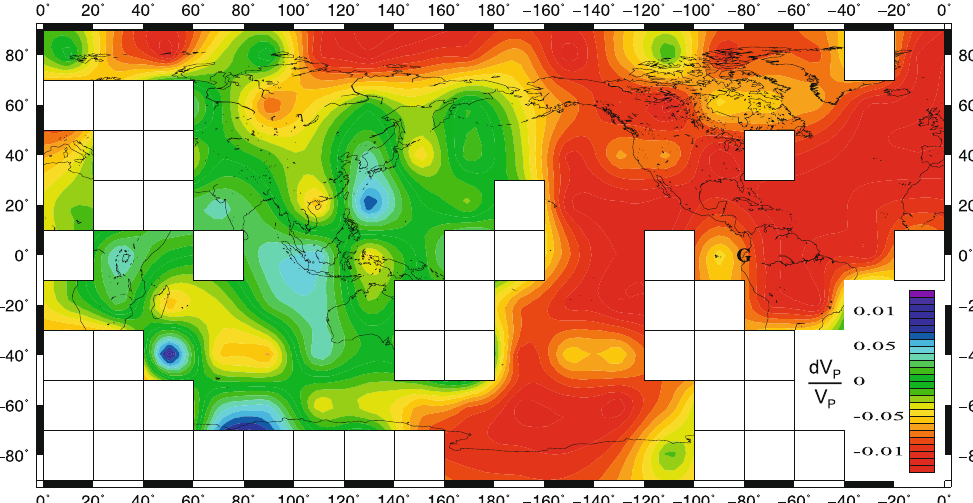
Figure 4. Velocity perturbations at the top of the inner core (first layer beneath ICB in ak135 model, depth from 0 to 51.11 km beneath ICB). Data have been interpolated with kriging method 34 and a low smoothing. White squares show the areas where the small number of rays did not allow reliable results. The model explains more than 80% in the initial variance (evaluated for null velocity perturbations). Point G at (0°, 80°W) is indicated. Figure produced with Generic Mapping Tools (GMT 5.1.2) 48 .